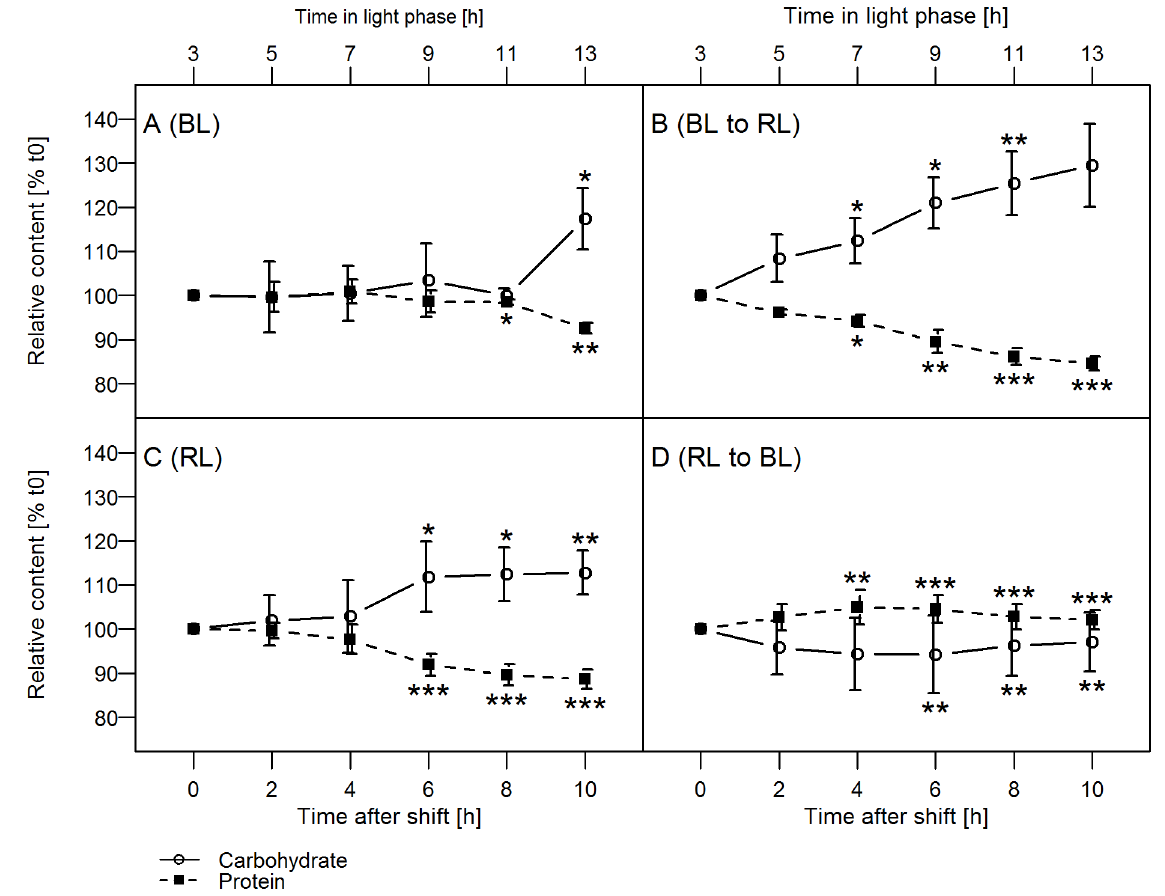
Figure 4. Carbohydrate and protein levels. The carbohydrate and protein levels of P. tricornutum cultures during the course of the day were determined for cultures pre-acclimated to (A) BL and (C) RL as well as (B) the changes after a shift from BL to RL and (D) RL to BL. Shown are the relative protein and carbohydrate contents in relation to the values measured at t 0 . The asterisks depict the p-values of the respective data point compared to t 0 for pre-acclimated cultures (A, C) or compared to the steady state the cultures were shifted from at the same time point (B, D). n=3– 6. The exact values are specified in Table S4.